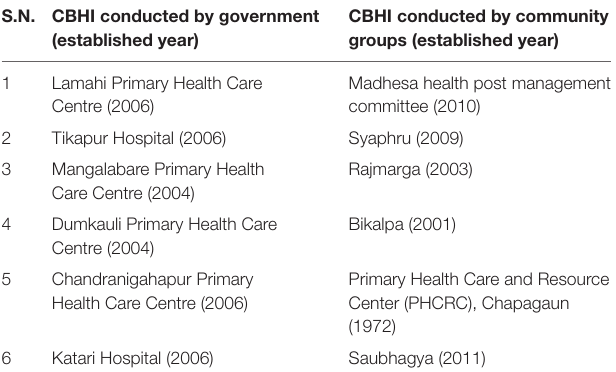
TaBle 2 | Community-based health insurance (CBHI) operated by government and community